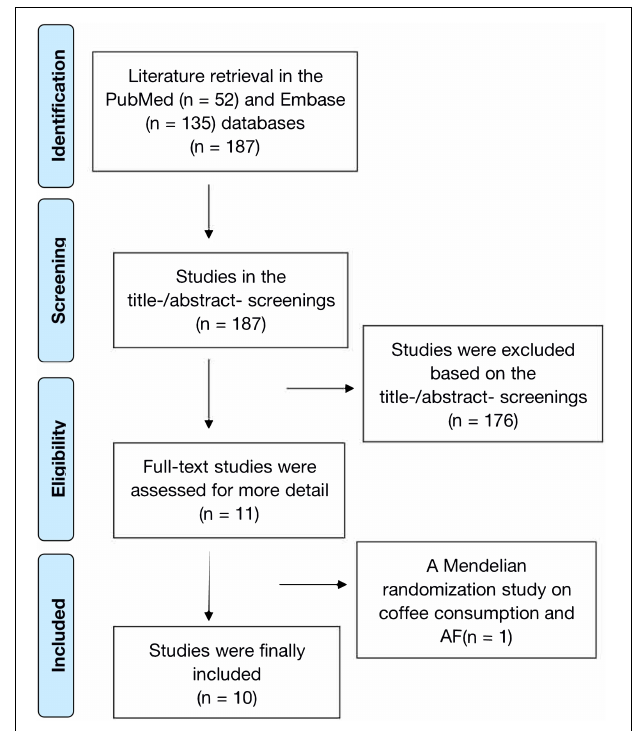
FIGURE 1 | Document retrieval flow chart of this